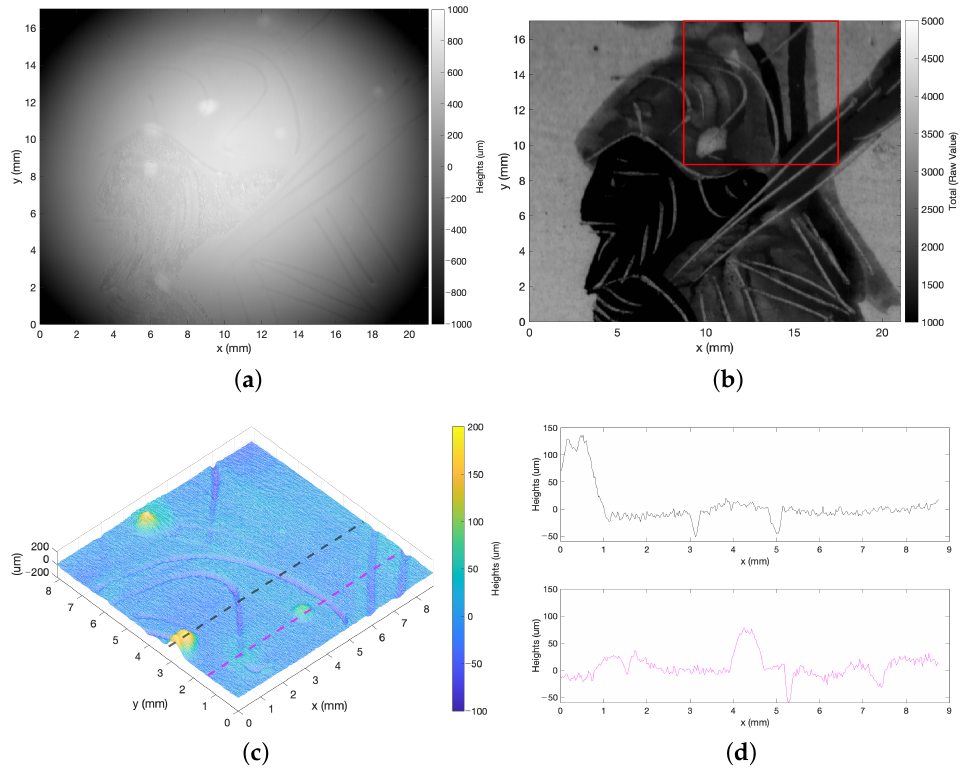
Figure 7. Combining intensity-height datasets in 3D polychrome artifacts: ( a ) Height map obtained by combining two optimized measurements. ( b ) Total values of the first scan mapped on the height map. ( c ) 3D visualization of the roughness texture of the highlighted red ROI. ( d ) Profiles plots exploration with reference to ( c ). Profilometer setup: Conopoint3, 75 mm lens, 25µm scan step, 10mm/s scan velocity.